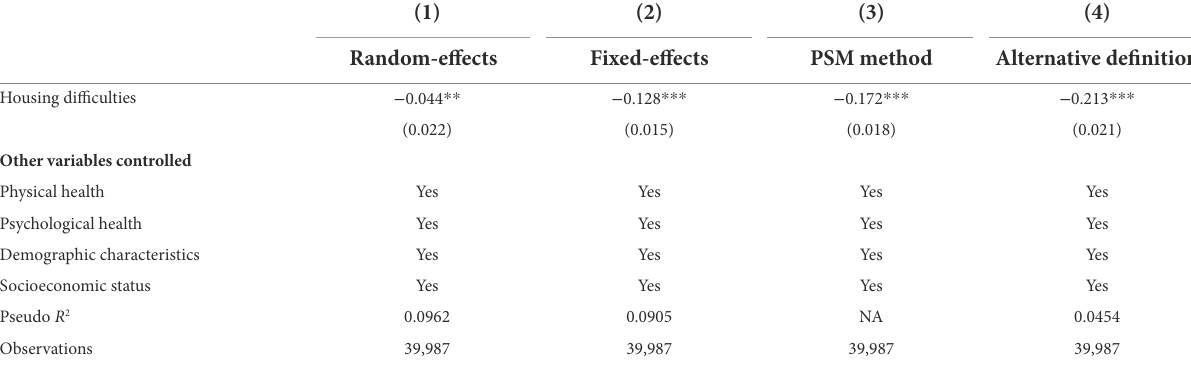
TABLE 5 Impact of housing difficulties on life satisfaction (robustness